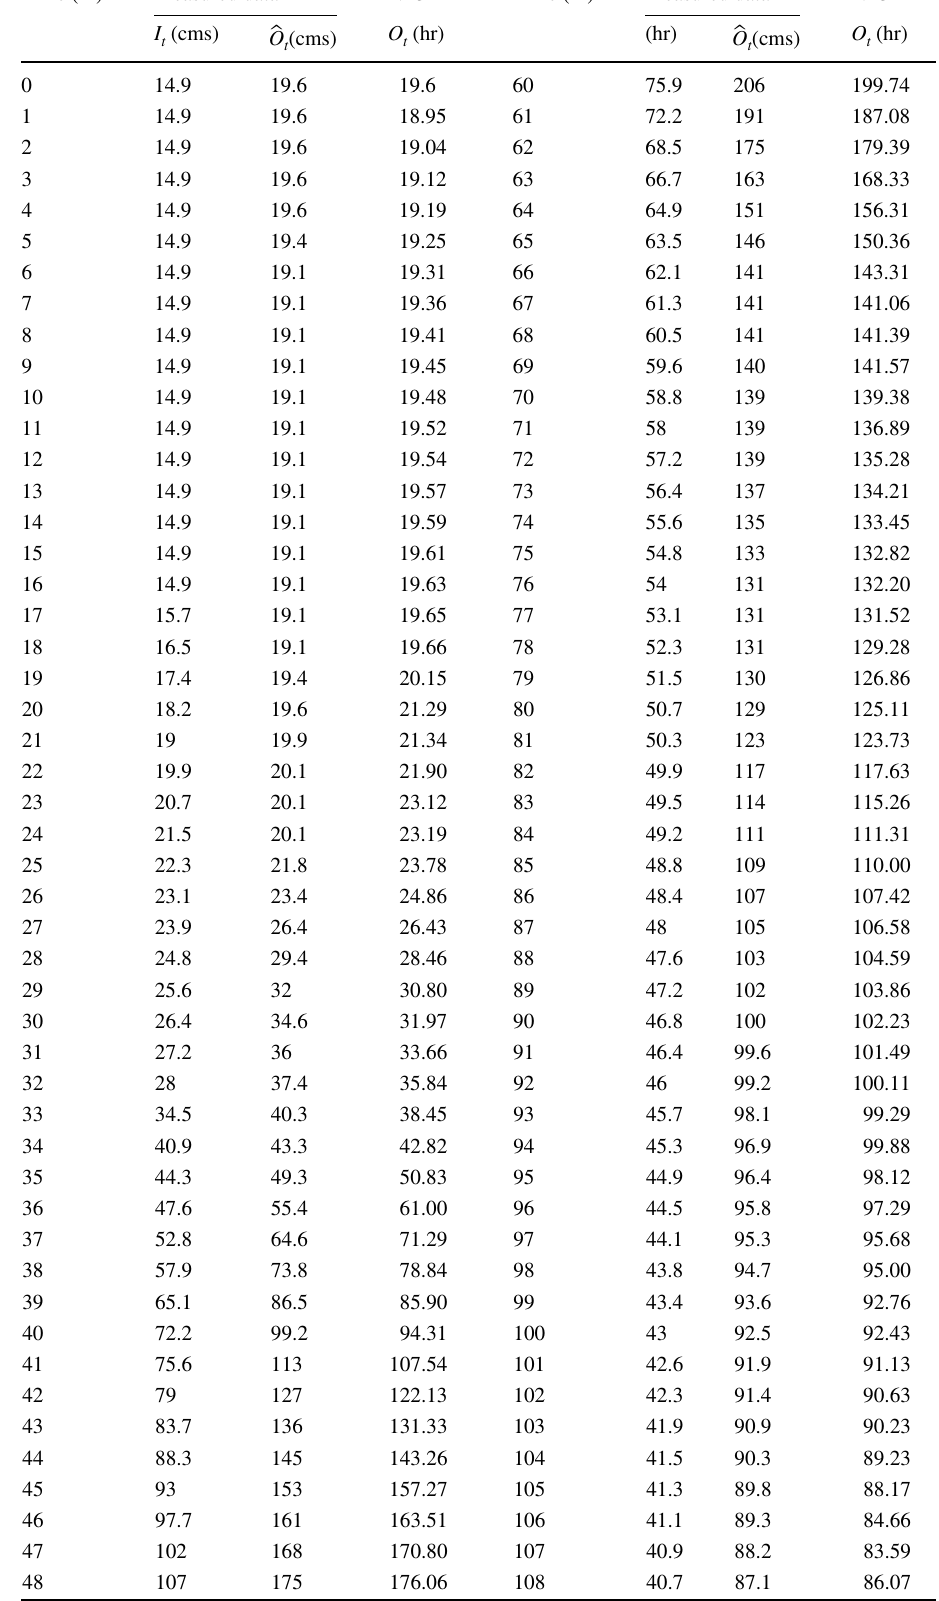
example (Dinavar River